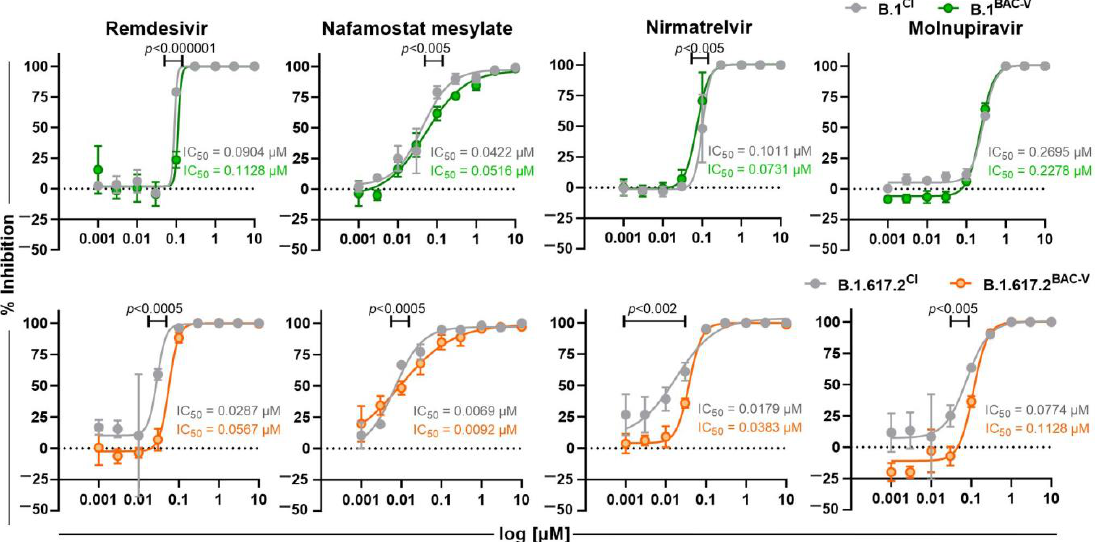
Figure 6. Efficacy of small molecule inhibitors Remdesivir, Nafamostat mesylate, Nirmatrelvir, and Molnupiravir against B.1 BAC-V (green), B.1.617.2 BAC-V (orange), and corresponding clinical isolates (CI, grey). Cells were infected at an MOI of 0.1 with indicated viruses. Graphs represent the % inhibition of infection determined by confluency measurement 48 hpi using Spark Cyto 400 multimode plate reader with cell imager and environmental control module. Displayed data were normalized to controls containing only virus but no inhibitors. IC 50 values were calculated by performing non-linear regression on the mean of three biological replicates indicated by the error bars. Single data points were compared using multiple unpaired t -tests. Significant comparisons are indicated by respective p values. The experiment was repeated twice yielding similar